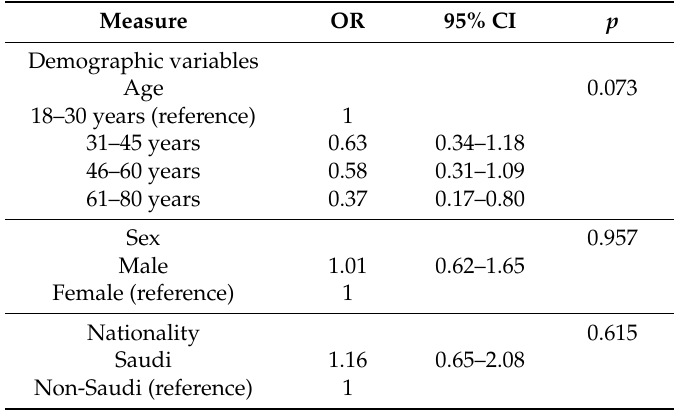
Table 3. Odds ratios and 95% confidence intervals for predictors of high risk for sleep apnea using the Epworth Sleepiness Scale (ESS).